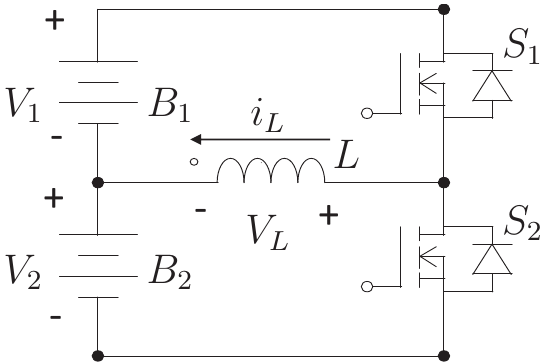
Figure 4. Module of the switched-inductor scheme applied to a two-cells battery